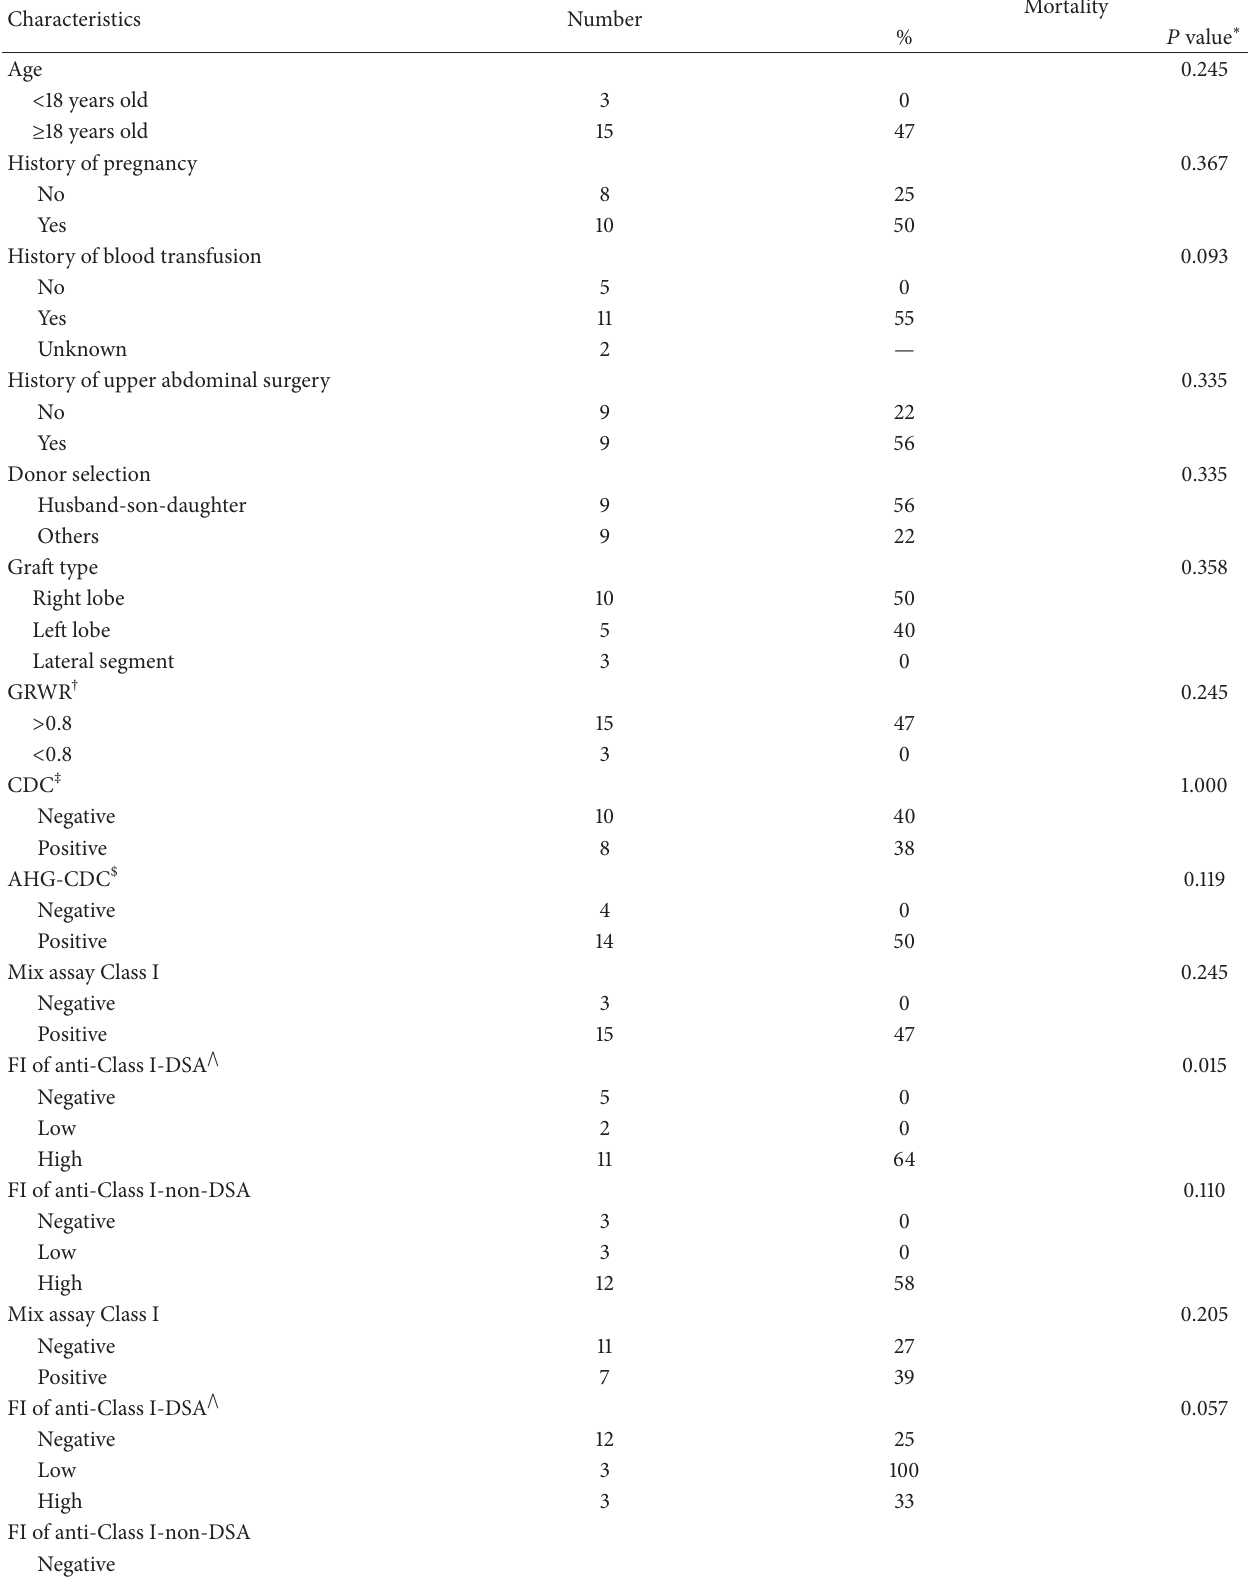
Table 3: Risk factors for